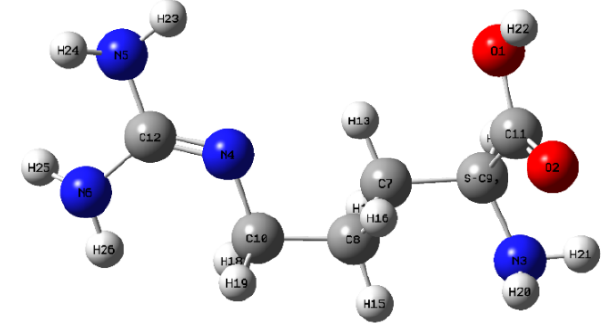
Figure 3. Single-molecule of